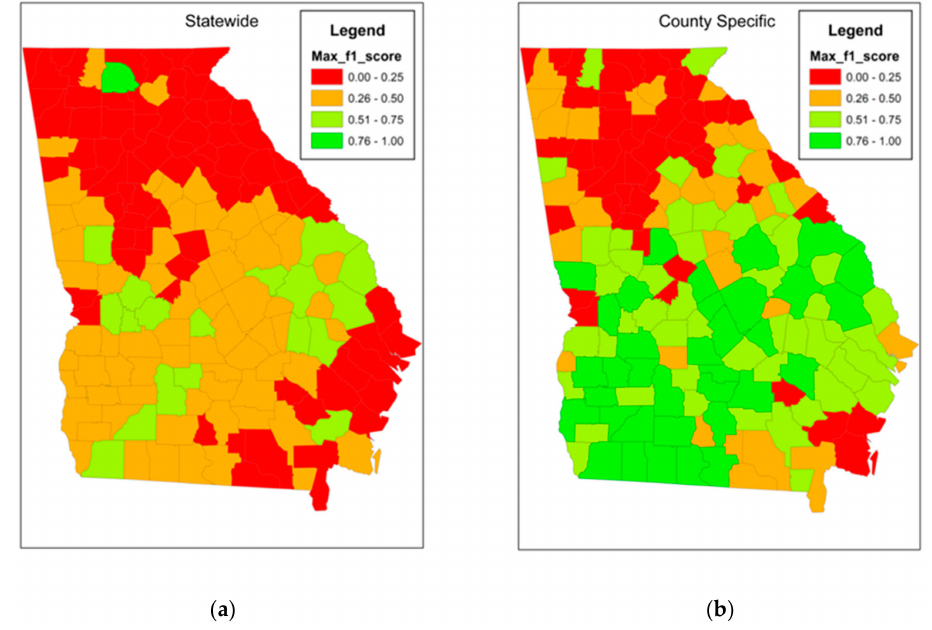
Figure 2. January–April 2015 burn day forecast F 1 scores by county for the ( a ) statewide and ( b ) county-specific decision tree